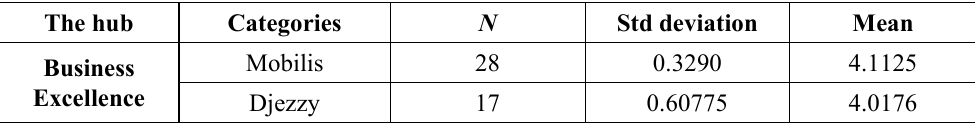
Table 8. Mean Comparison